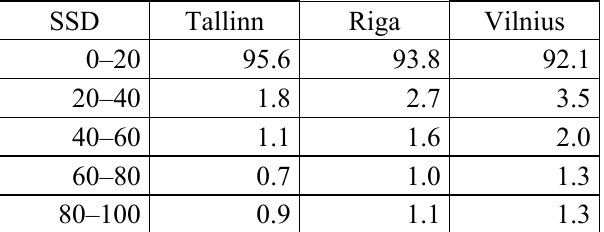
Table 3. Relative coverage of the degree of soil sealing values within FUAs